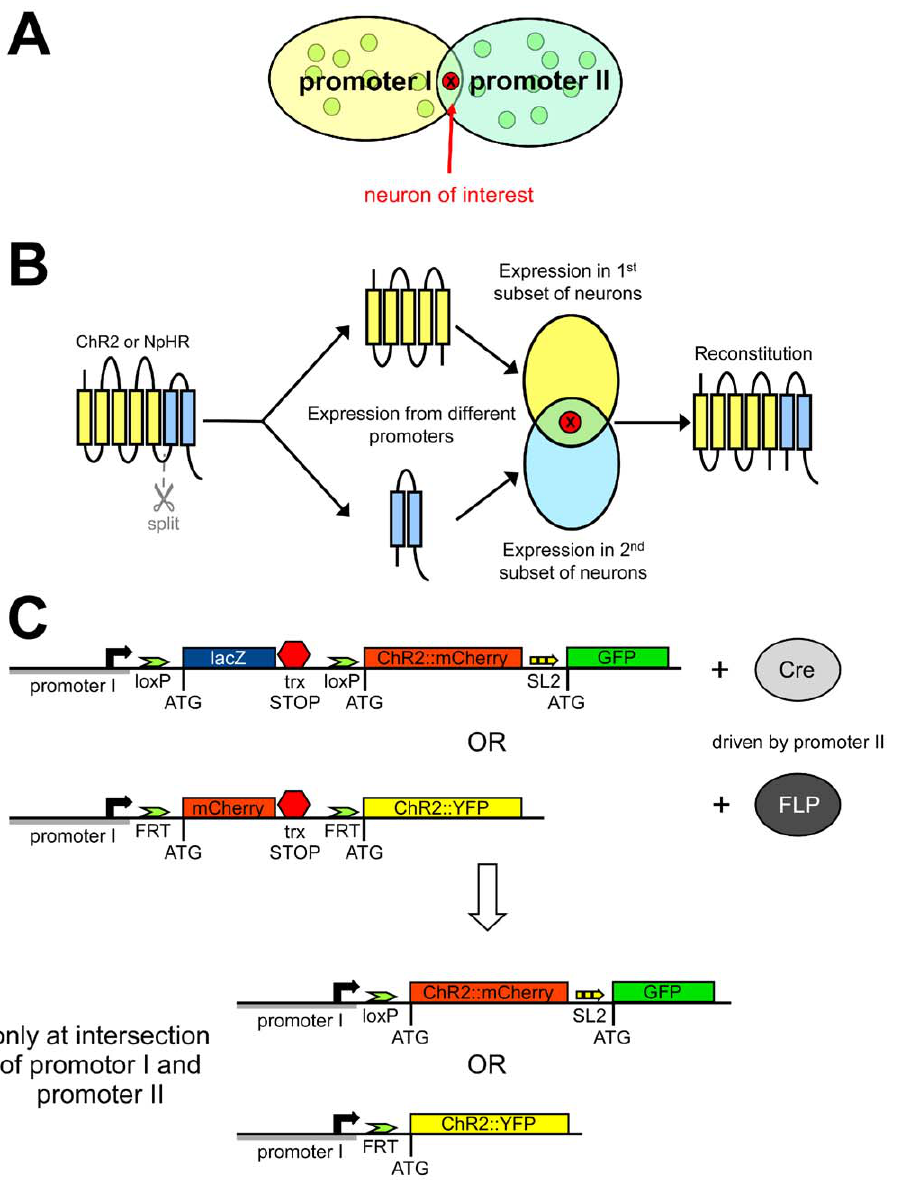
Figure 1. Conditional expression of ChR2 in single neurons using two promoters of intersecting expression domain, and DNA recombinases. A ) Two promoters, each expressing in a different set of neurons, with overlapping expression in one neuron only. B ) Concept of achieving conditional expression using split proteins that can reconstitute functional ChR2 or NpHR in the neuron of interest. See also Fig. S1. C ) Conditional expression is achieved by encoding ChR2 form a construct (driven by promoter I) that is blocked by a transcriptional stop cassette (red hexagon) between promoter and ChR2 start codon, and is flanked by recombinase recognition sites (loxP or FRT sites, recognized by Cre or FLP recombinases, respectively). The respective recombinase is driven by promoter II, to generate a transcription-competent DNA construct encoding ChR2 and (optionally) soluble GFP from a bicistronic expression cassette ( via SL2 trans-splicing).